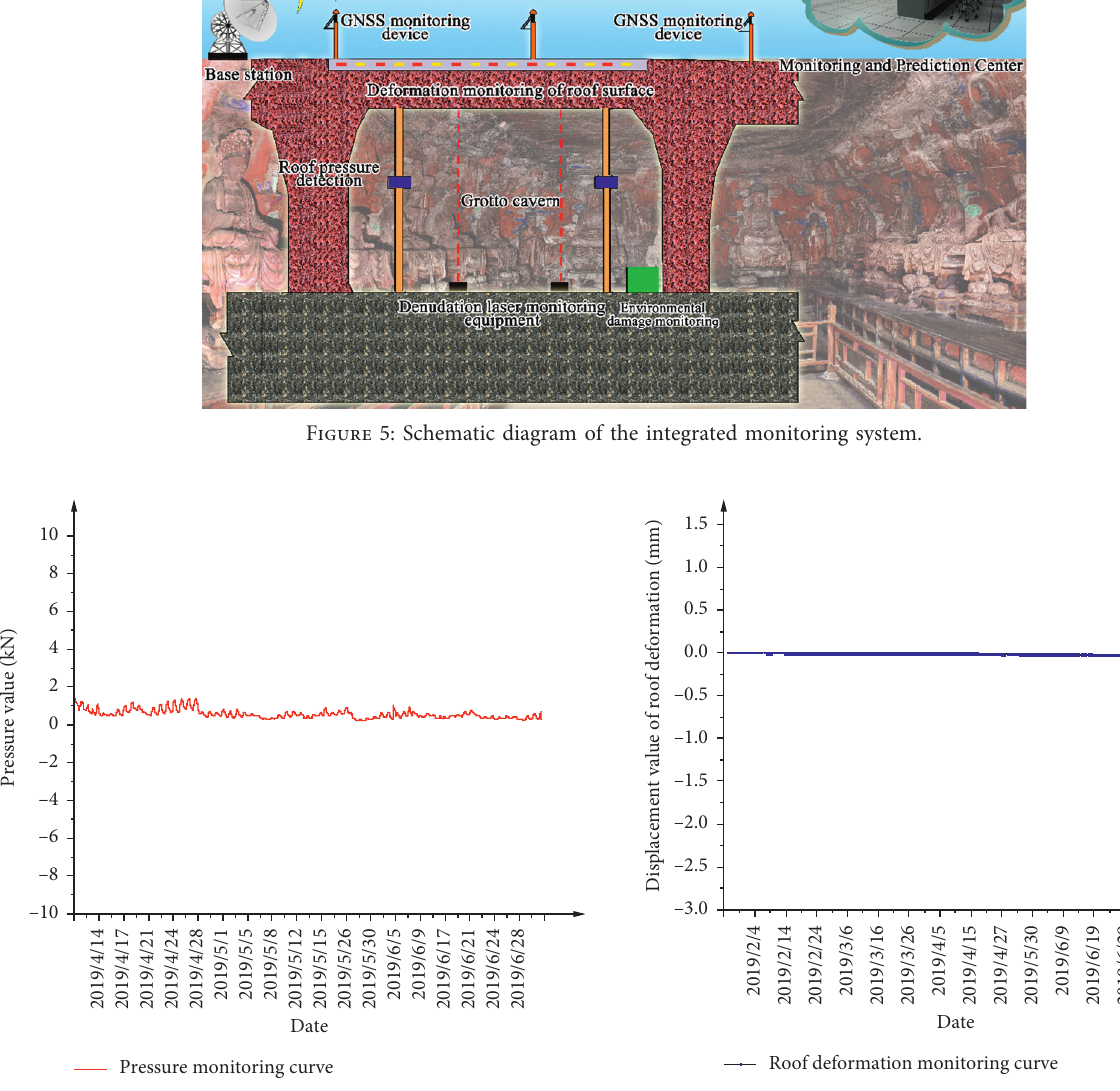
Figure 6: Roof pressure monitoring curve. Figure 7: Monitoring curve of roof deformation through the grating monitoring